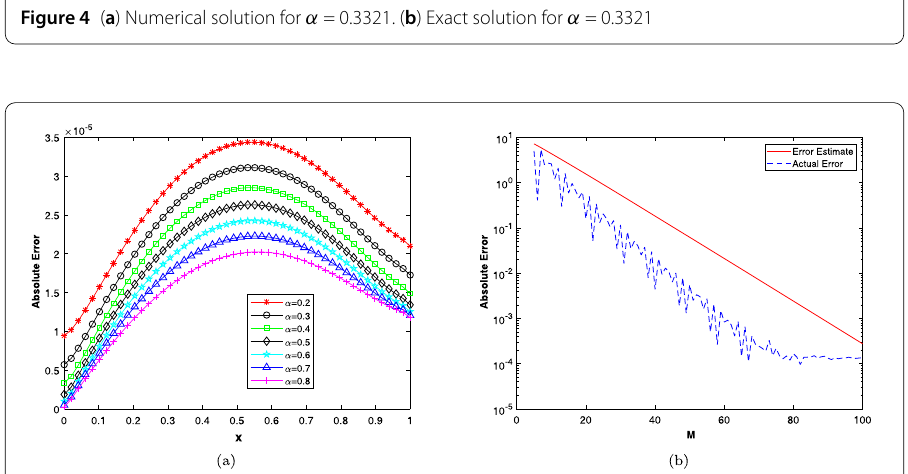
Figure 5 In ( a ) absolute errors for different α , the error decreases as we increase α . In ( b ) the actual error and error estimate are shown and good agreement is observed